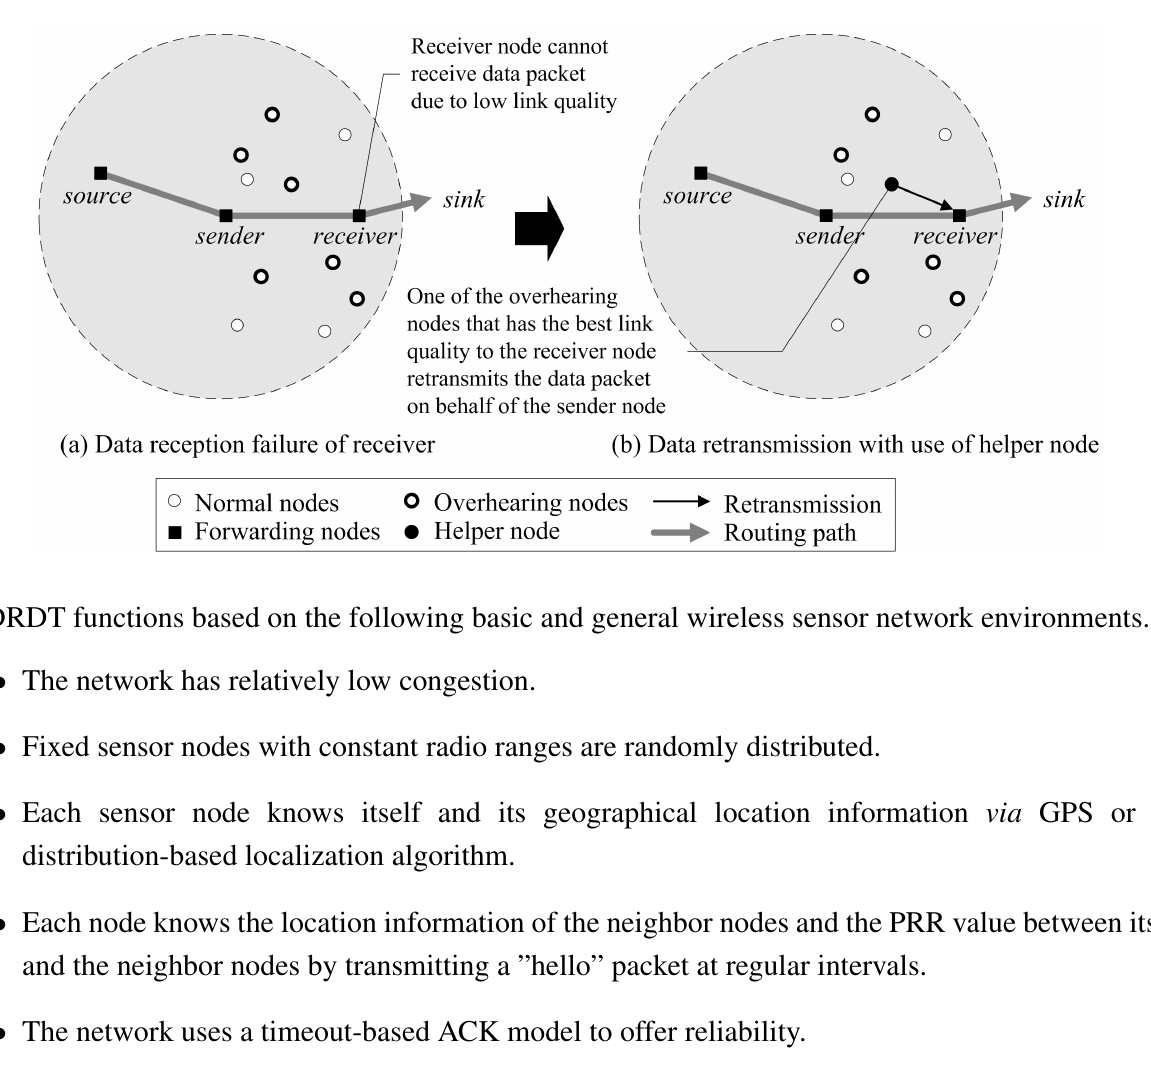
Figure 2. Overview of proposed DRDT